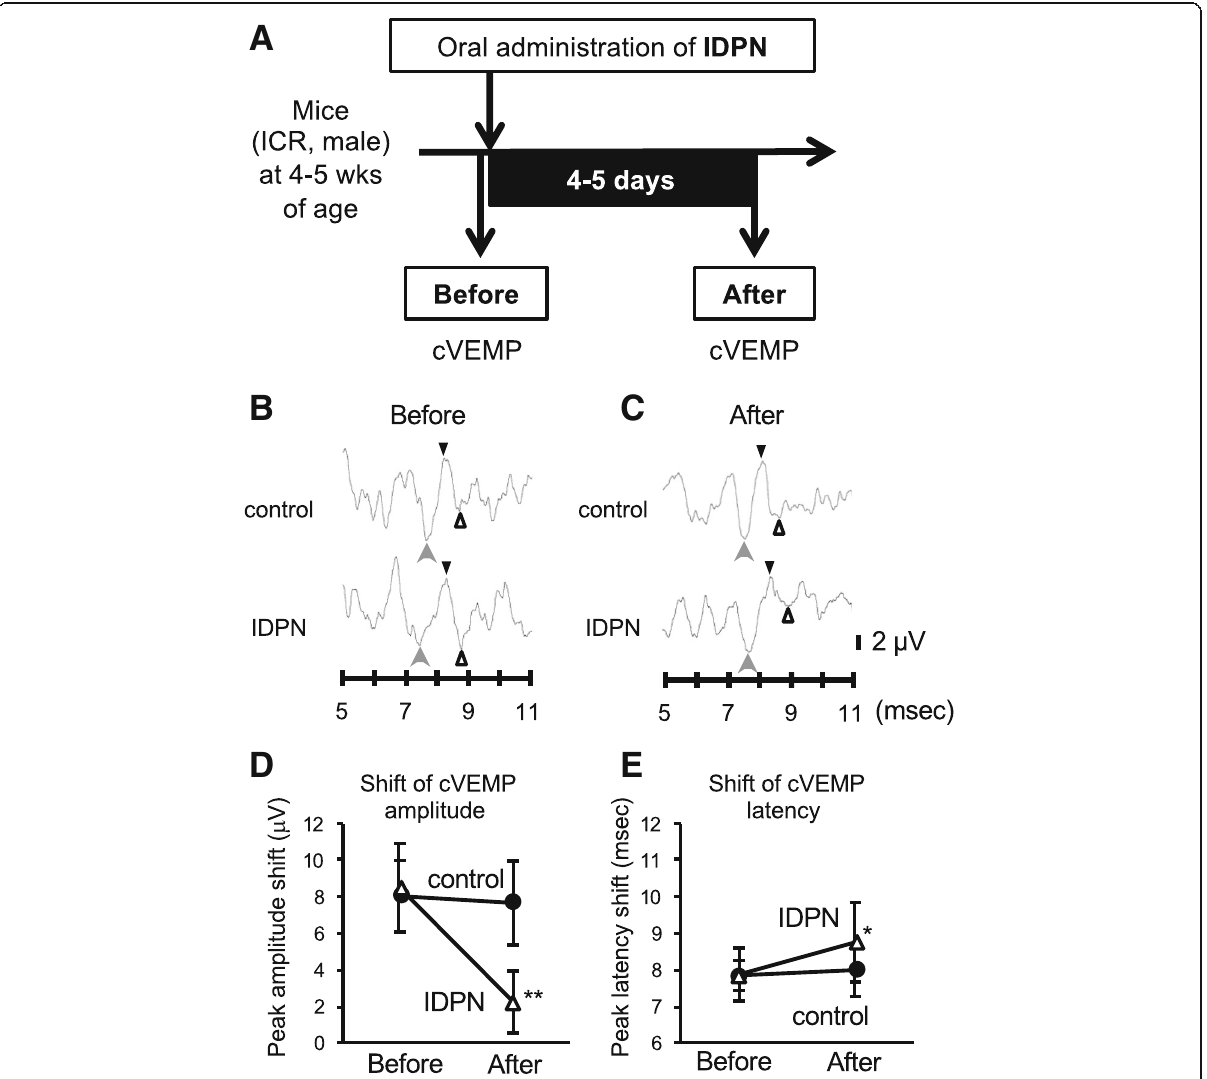
Fig. 3 Impairments of cVEMP in the IDPN group and a scheme of experiments. a Scheme of experiments. cVEMP recordings were performed following oral administration of IDPN in male mice in the control group ( n =5) and the IDPN group ( n =5). cVEMP recording was performed after the administration of IDPN. b , c cVEMPs in the control group (upper waves) and the IDPN group (lower waves) before ( b ) and after administration of IDPN ( c ) are shown. cVEMPs with a positive peak (p1, indicated by black triangles) and those with a negative peak (n1, indicated by white triangles) were identified by the appearance of negative waves (indicated by gray arrows) just before p1 indicated by black triangles. d , e Graphs of cVEMP amplitudes [microvolts ( μ V), mean±SD in e ] and latencies [milliseconds (msec), mean±SD in e ] in the control group (black circles, n =5) and the IDPN group (white triangles, n =5) before and after administration of IDPN are presented. Significant differences (** p <0.01; * p <0.05) between the two groups were analyzed by Welch ’ s t